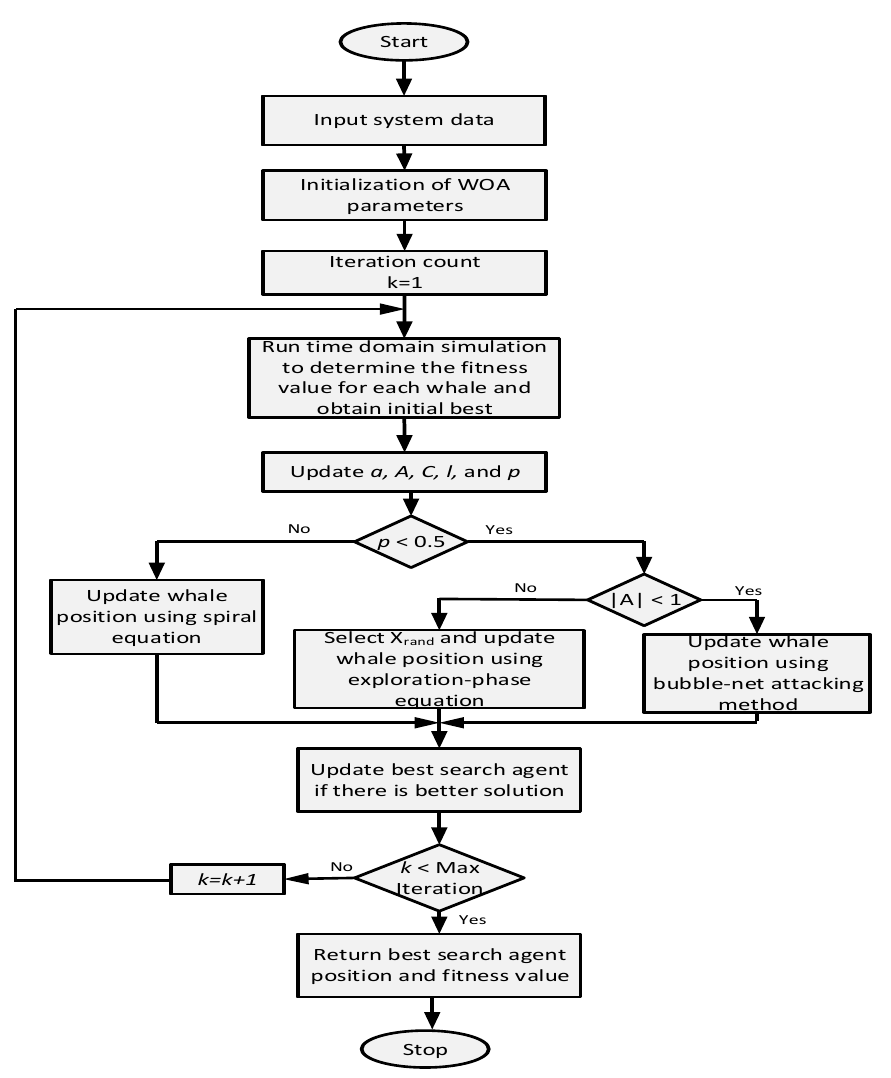
Figure 6. The WOA flow chart for optimizing control parameter.